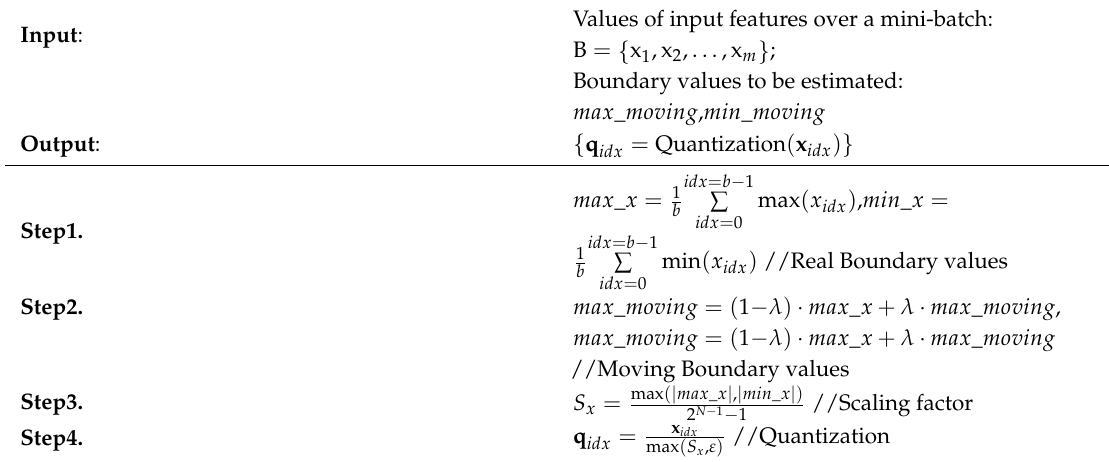
Algorithm 1 The forward-propagation algorithm of quantization sub-layer for input